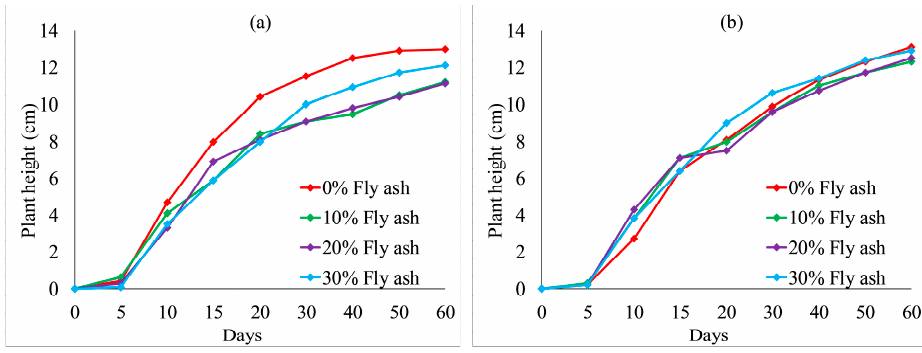
Figure 14. Ryegrass height relative to wheat straw content combined with: ( a ) 5% KW fertilizer con- tent; ( b ) 10% KW fertilizer content.